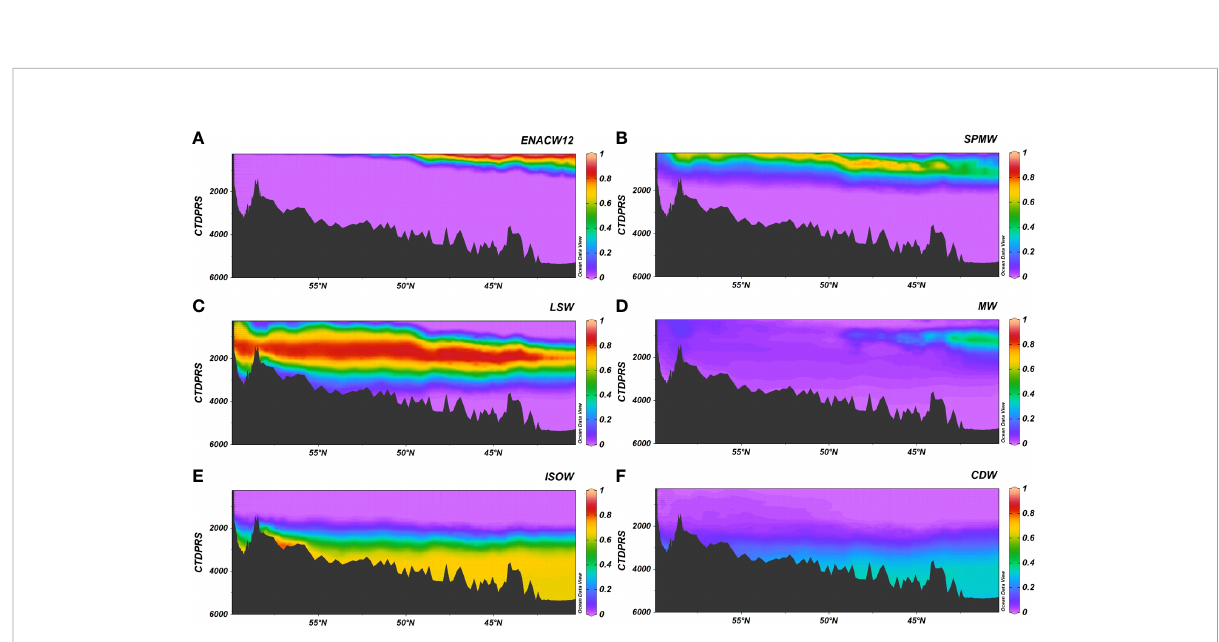
FIGURE 8 A25 section for the contribution of the water masses (A) ENACW12, (B) SPMW, (C) LSW, (D) MW, (E) ISOW, (F) CDW. Figure with the Ocean Data View software (Schlitzer,